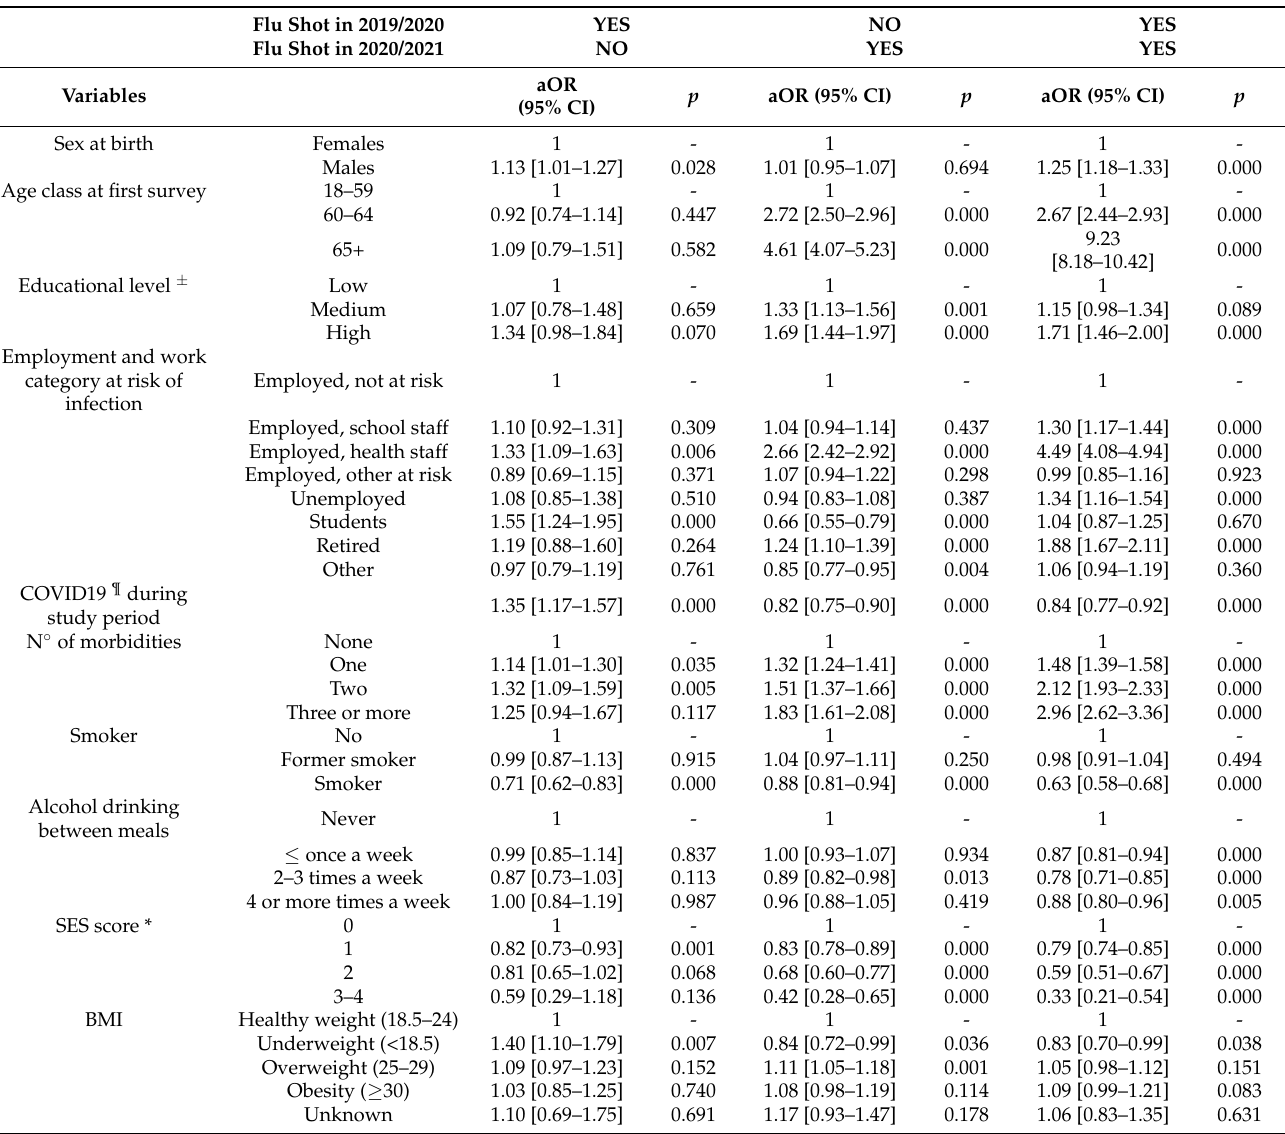
List of abbreviations: CI, confindence interval; aOR, adjusted odds ratio. ± Categorized as low (primary school or less), medium (middle or high school) or high (university degree or post-graduate). * Calculated in accordance with Townsend et al. [20]. ¶ Defined as those who reported at least one positive result for a nasopharyngeal swab (NPS) or a serological test (ST) during the considered study